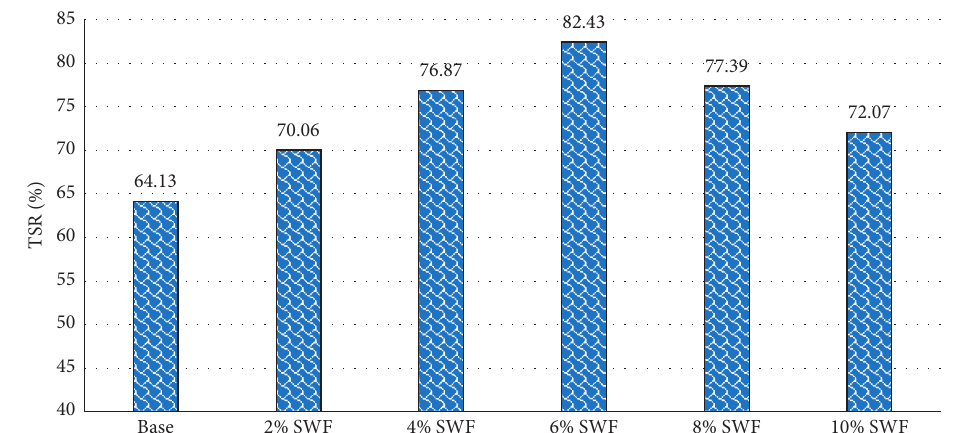
Figure 5: The TSR results of unmodified and modified asphalt mixtures.